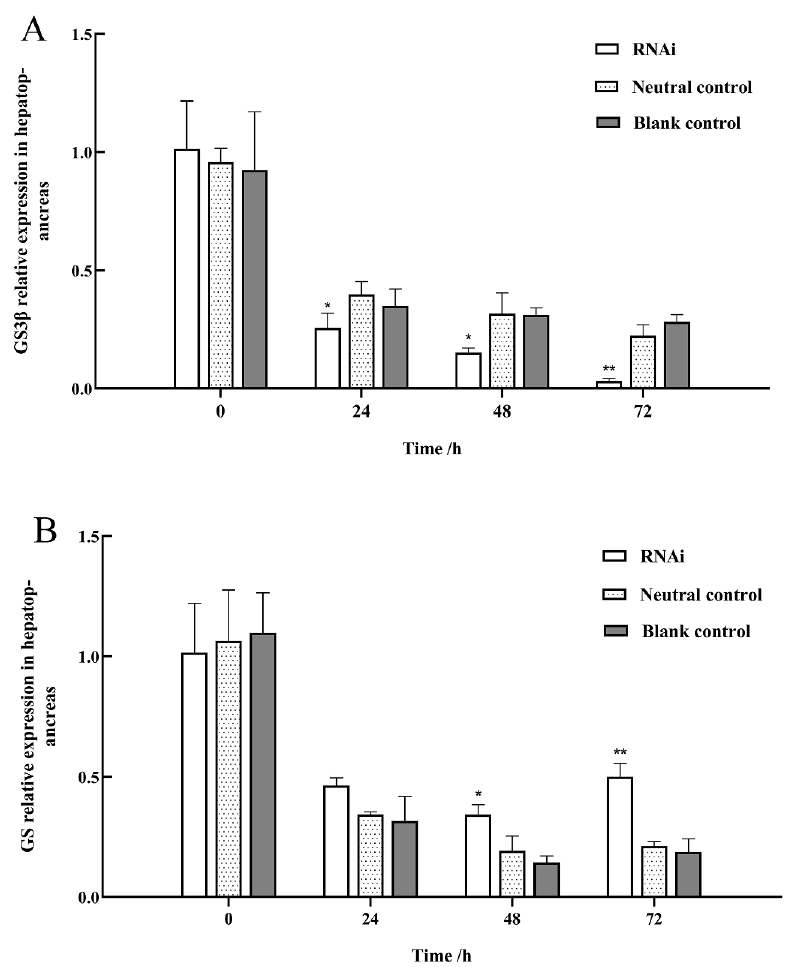
Figure 7. GSK3β ( A ) and GYS ( B ) expression after dsRNA injection in hepatopancreas (n = 3). The asterisk indicates significant difference (p < 0.05) between RNAi and neutral control group. The double asterisks indicate highly significant differences between RNAi and neutral controls (p < 0.01).